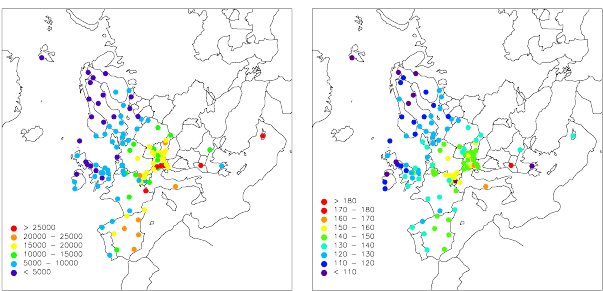
Fig. 12. Five years means of the 6-months AOT40 (left) and the 6- months 99 percentile ( p 99 ) averaged over the years 2005–2009. The summer half year (April–September) was used for both parameters. AOT40 values are in ppb h. The 99 percentiles are in µgm − 3 .